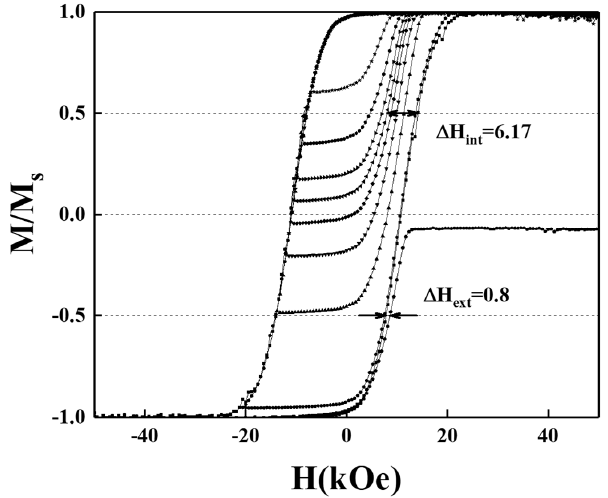
Figure 14. Magnetization curves include major and minor hysteresis loops of the BN/FePtCAg/MgTiON film. Switching field distribution was evaluated by measured loops.